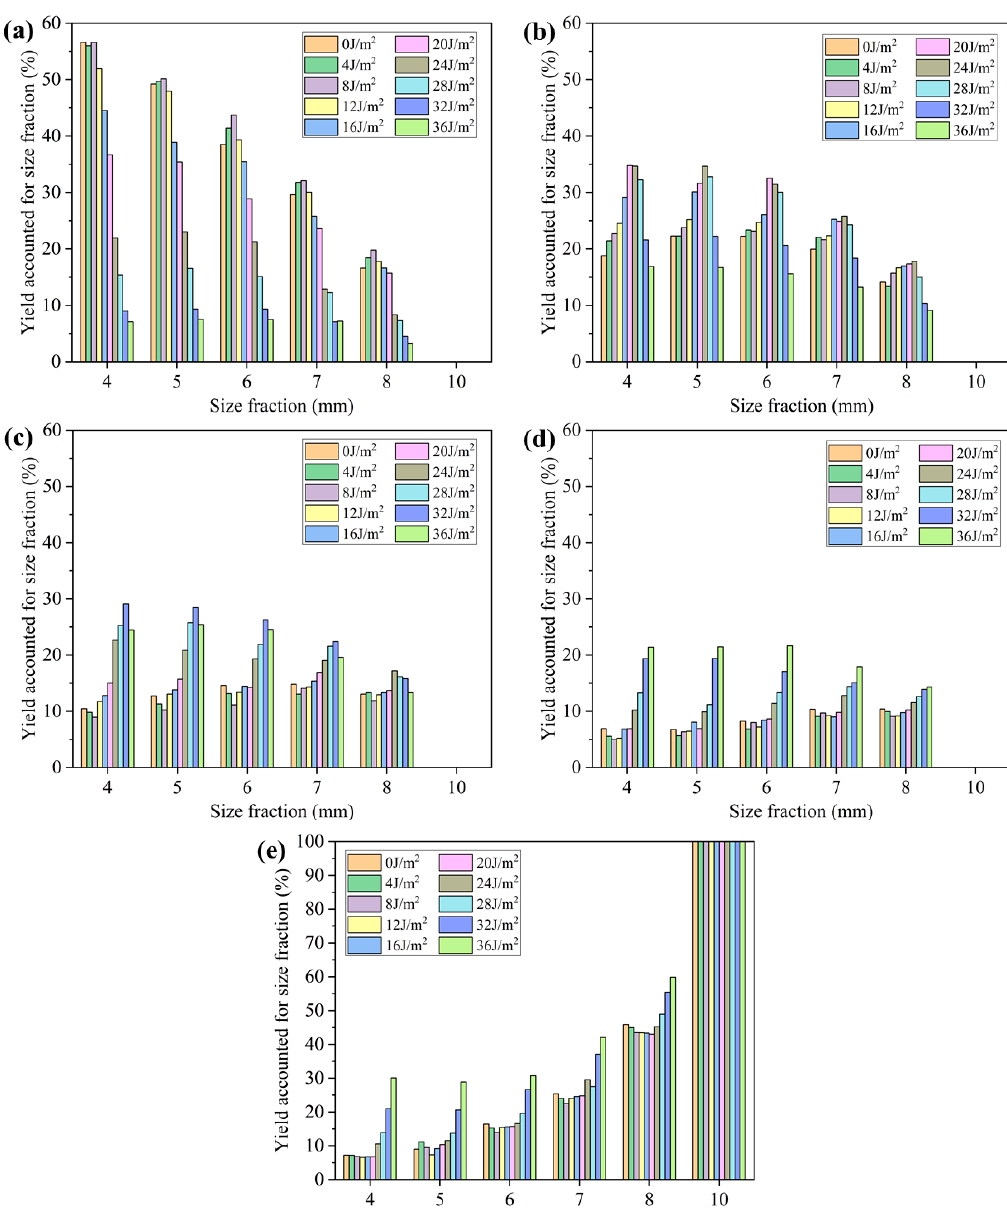
Figure 9. Comparison of the particle size distributions captured into Sections 1 ( a ), 2 ( b ), 3 ( c ), 4 ( d ), and 5 ( e ) with different surface energy levels.